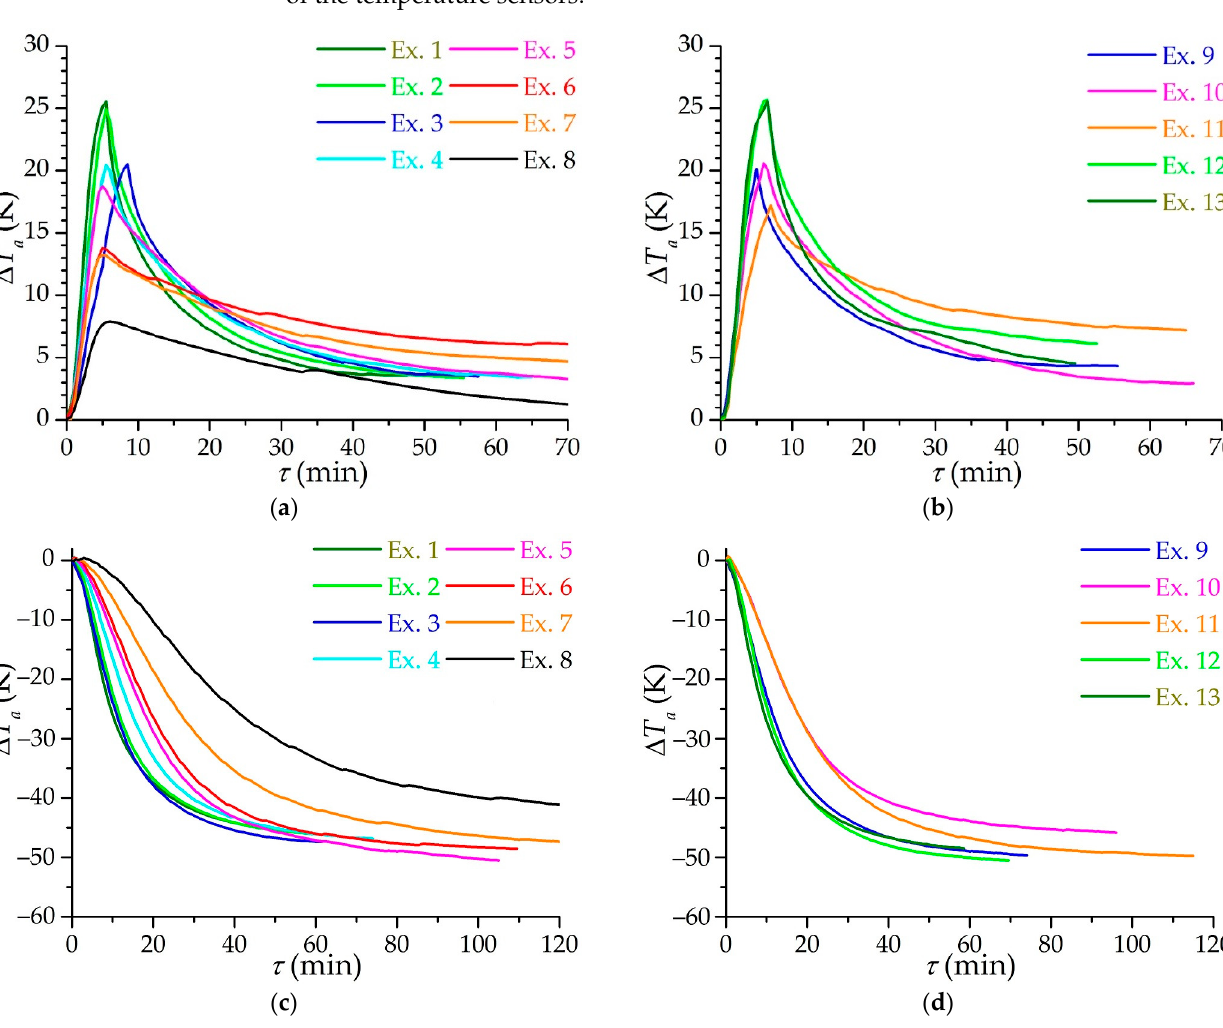
Figure 9. Time dependence of the adsorbent average temperature change during isothermal ( a , b ) and low temperature ( c , d ) circulating charging. Subfigures ( a , c ) refer to the main group of experiments (from 1 to 8), and subfigures ( b , d ) to additional experiments (from 9 to 13) with a constant flow mode.